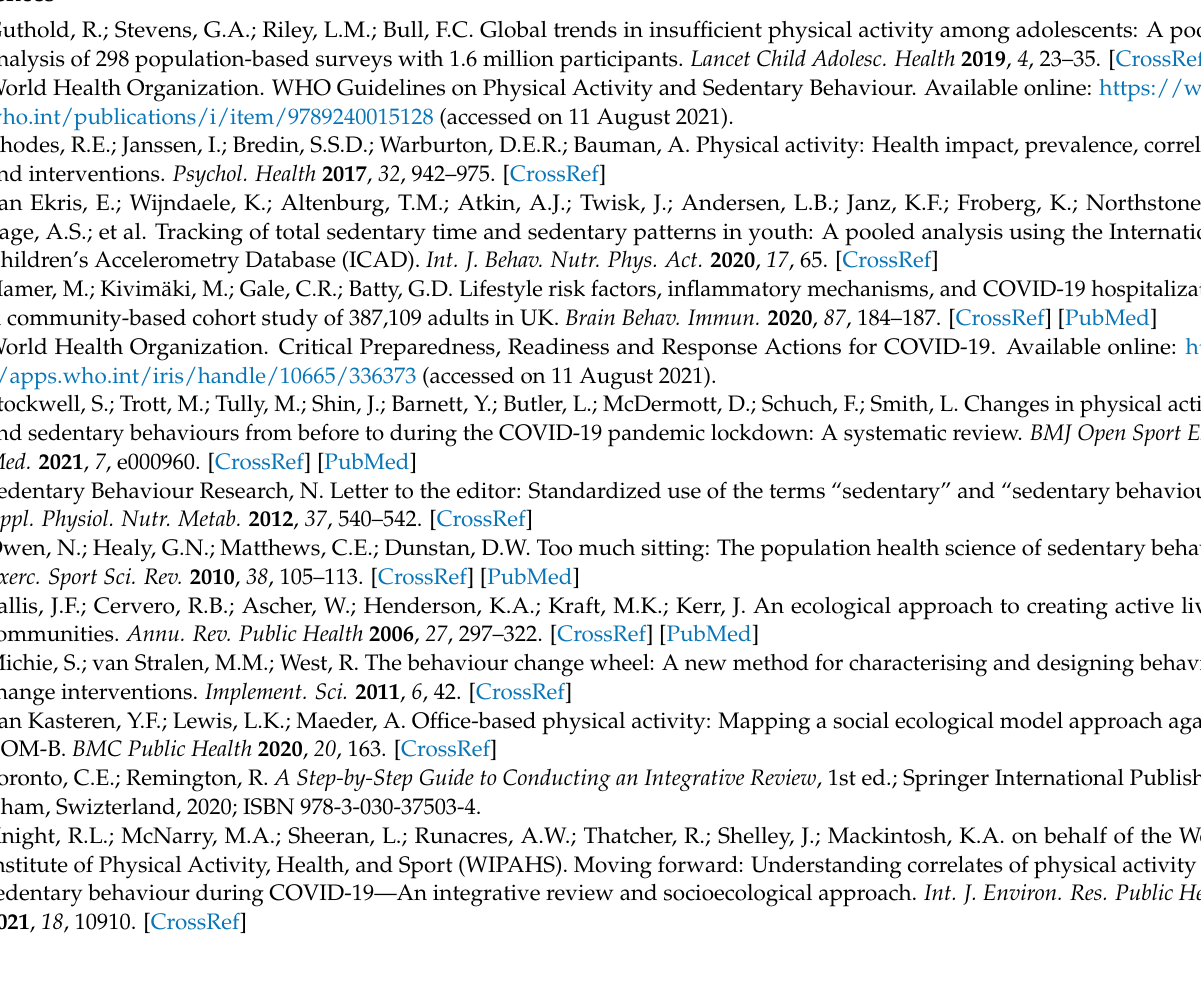
Table S1: Study characteristics; Table S2: Coding criteria for the Mixed Methods Assessment Tool; Table S3: Quality assessment results from Mixed Methods Assessment